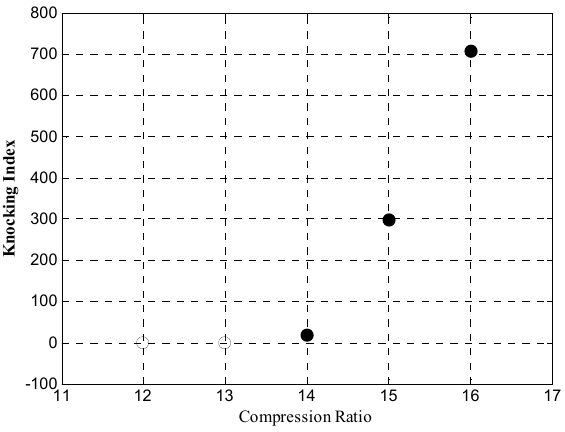
Figure 21. Natural induction time integration with different compression ratios.